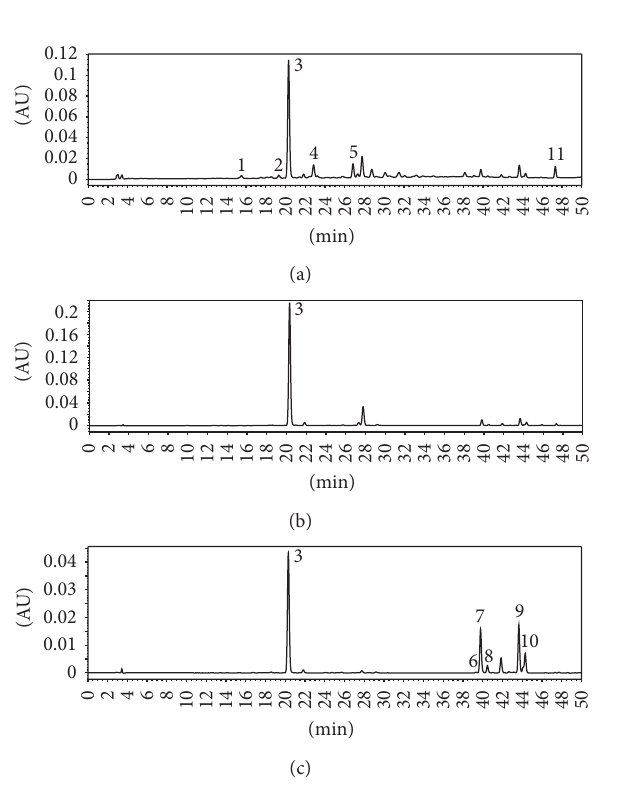
Figure 4: Chromatograms of ethanol extracts of the investigated apple samples (cv. “Aldas”): (a) 𝜆 = 280 nm; (b) 𝜆 = 320 nm; (c) 𝜆 = 360 nm. Numbers indicate the peaks of analytes: 1: